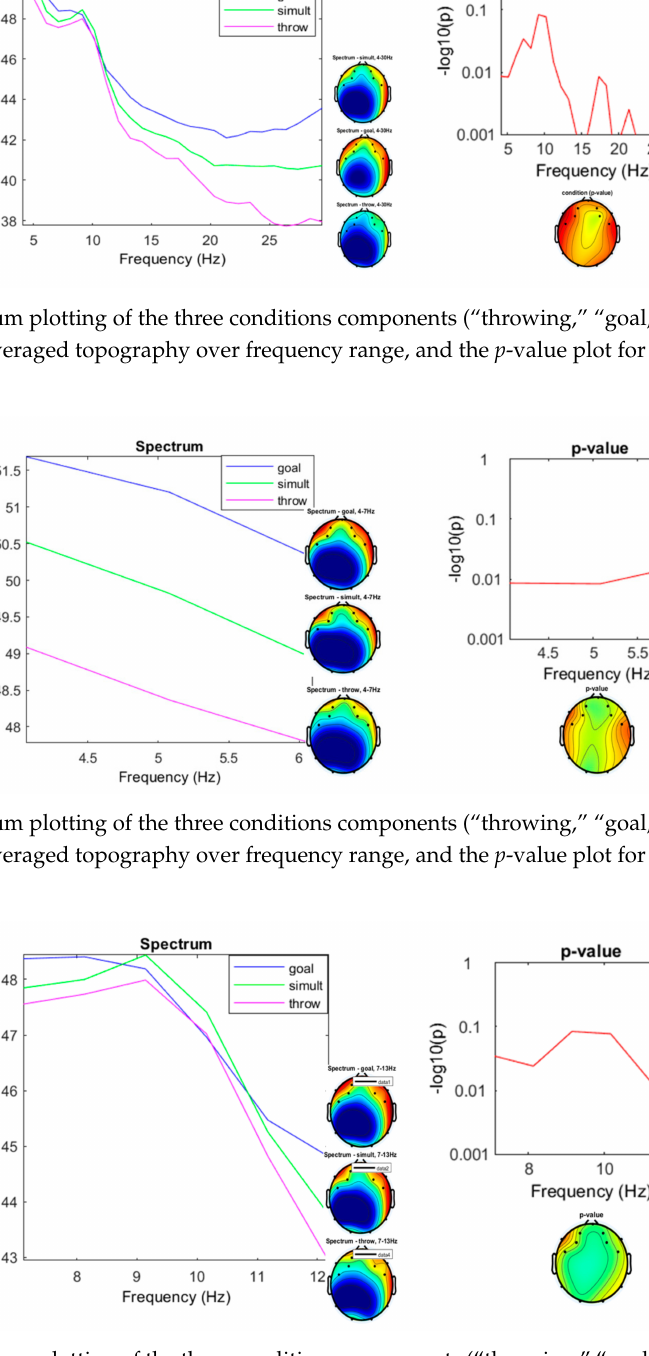
Figure 10. Spectrum plotting of the three conditions components (“throwing,” “goal,” “simultaneous”), with their plot averaged topography over frequency range, and the p -value plot for frequencies from 7 to 13 Hz (alpha).